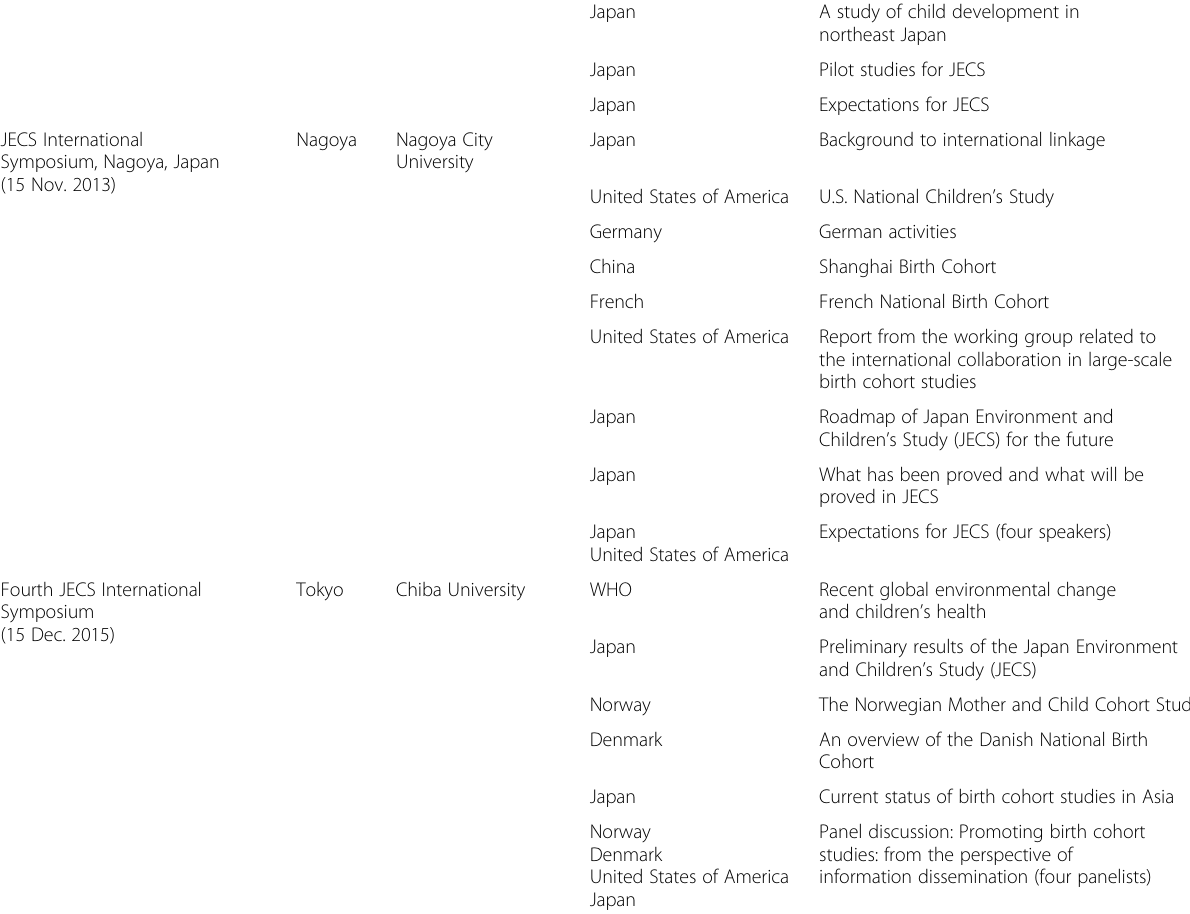
Table 1 JECS international symposia